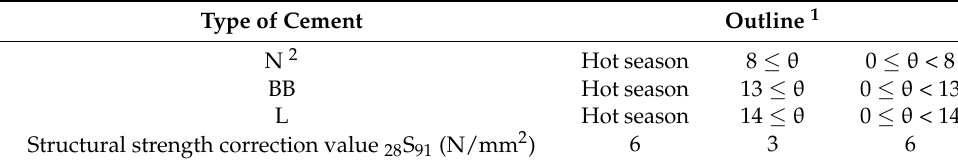
Table 2. Structural strength correction value 28 S 91 . Type of Cement Outline